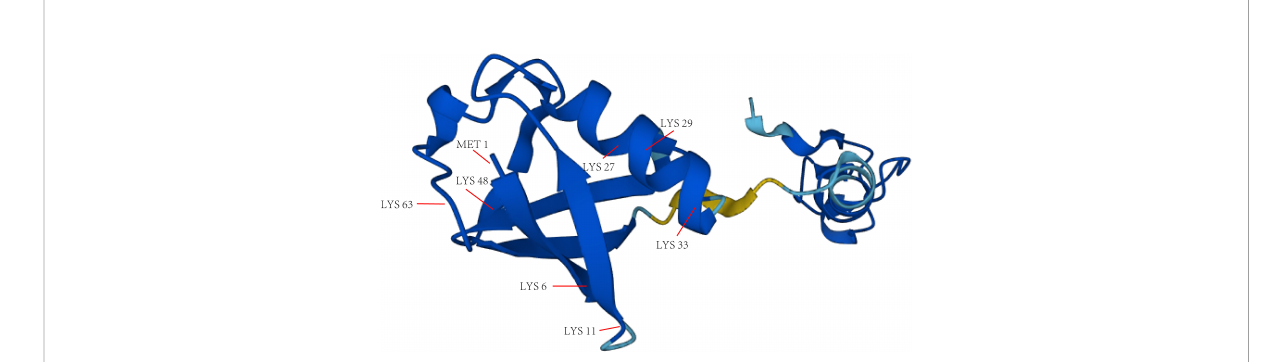
FIGURE 2 The main lysine residues and N-terminal methionine of Ub. The structure picture of Ub is from alphafold.ebi.ac.uk.